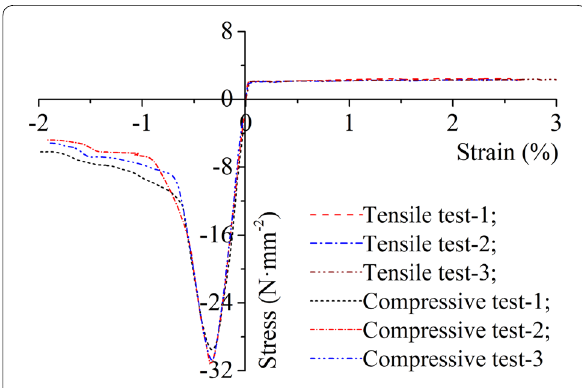
Fig. 2 Stress–strain of unfrozen